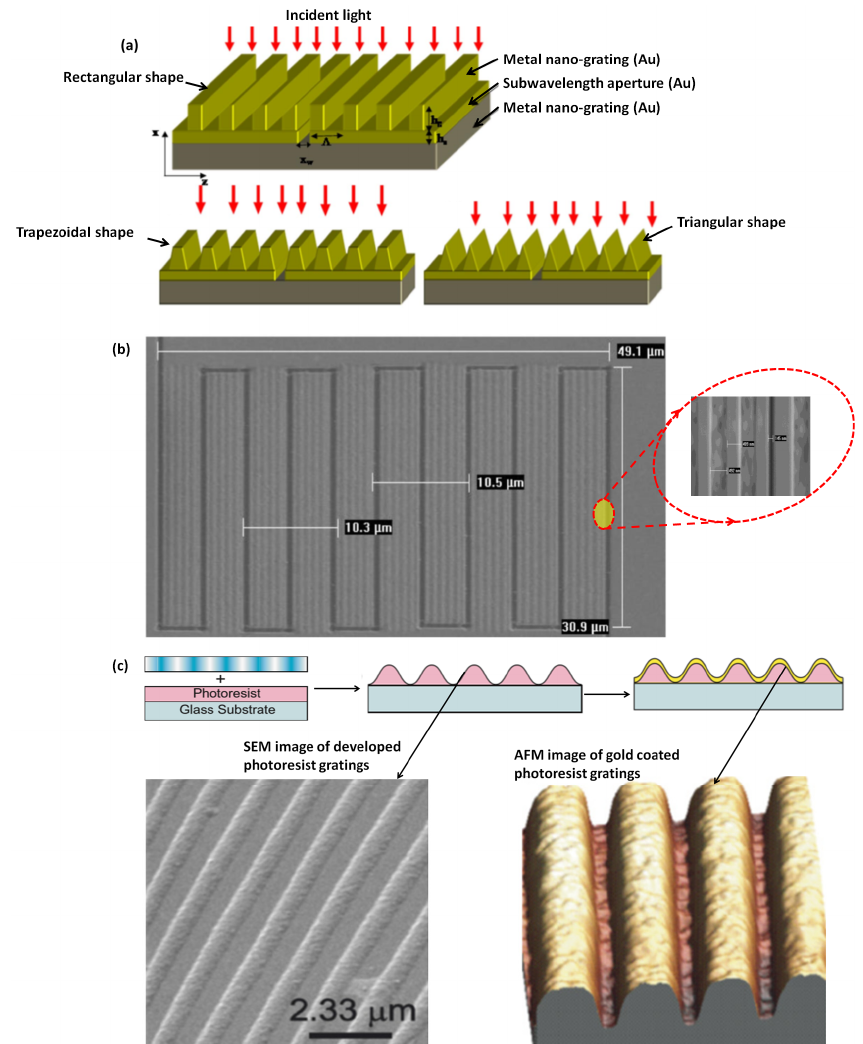
Figure 3. The schematic diagram for various types of nano-grating structures (a) , SEM image of developed nano-grating structures prepared by using dual-beam FIB lithography process (b) , and photo-resist nano-grating (uncoated and gold coated) structures developed on glass substrates by using simple spin-coating and sputtered deposition process, and their AFM and SEM images (c) [44,72]. Figure 3 (c), has been Adapted and reprinted from ref. 44, Copyright (2007), with permission from Elsevier B. V.